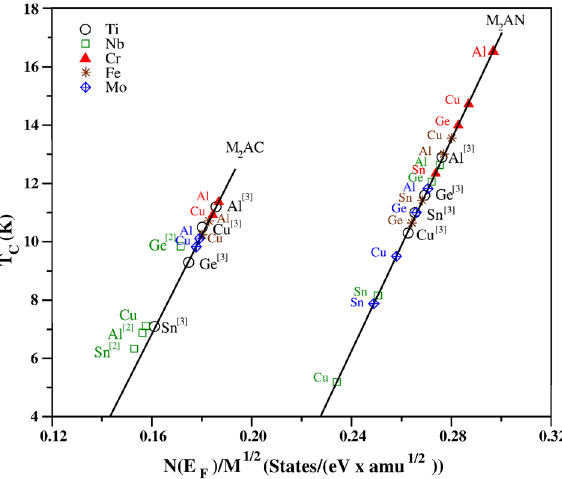
Figure 3. T c for M 2 AX (M: Ti, Cr, Fe, Nb and Mo; A: Al, Cu, Ge and Sn; X: C and N). New data in this paper for M = Ti, Nb, Cr, Fe, and Mo are shown as black circles, green squares, red filled triangles, brown stars and blue diamonds, respectively. Data from our recent studies 2,3 on Nb 2 AC and Ti 2 AX are shown in brackets. Full data in Table